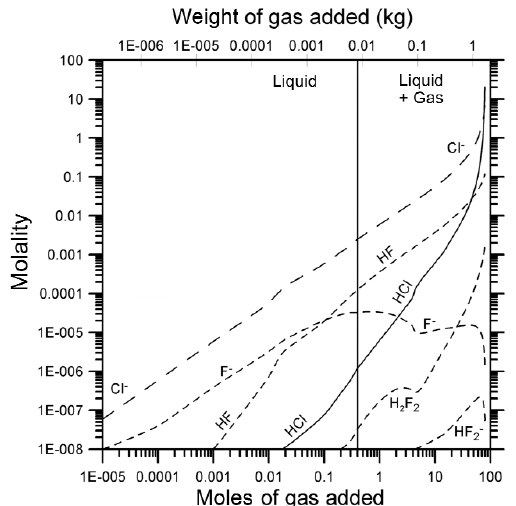
Fig. 9. Changes in dissolved chloride and fluoride species during the progressive addition of hot (915°C) magmatic gas into 1000 g of pure water ini- tially at 25°C. Pressure was kept at 0.1 MPa through- out the simulation.